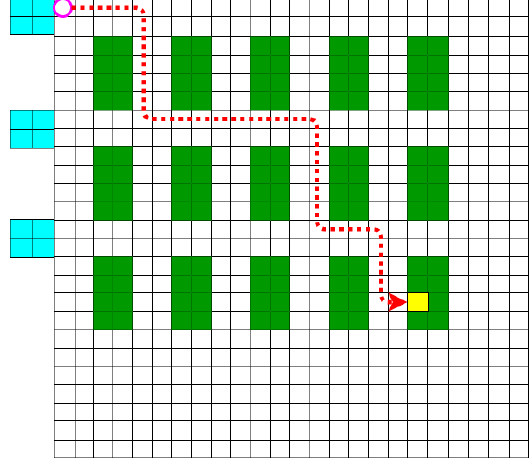
Figure 9. Target position of simulation experiment.